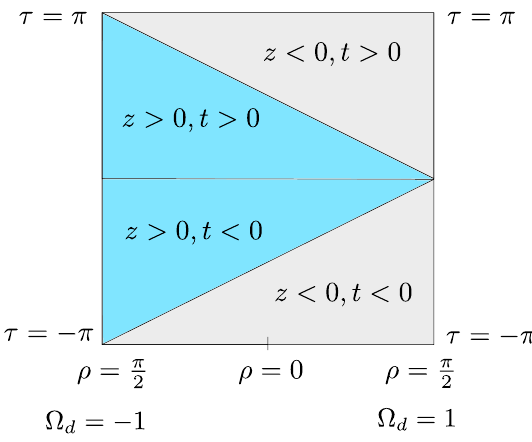
Figure 1 . The Penrose diagram for Lorentzian AdS space. The region in blue is spanned by the Lorentzian Poincaré coordinates (known as the Poincaré patch). The region in grey is the exempted region. The full box is spanned by the Lorentzian global coordinates. As is evident, half of the AdS boundary (denoted by ρ = π/ 2 and Ω = 1 ) is not covered by the Poincaré d